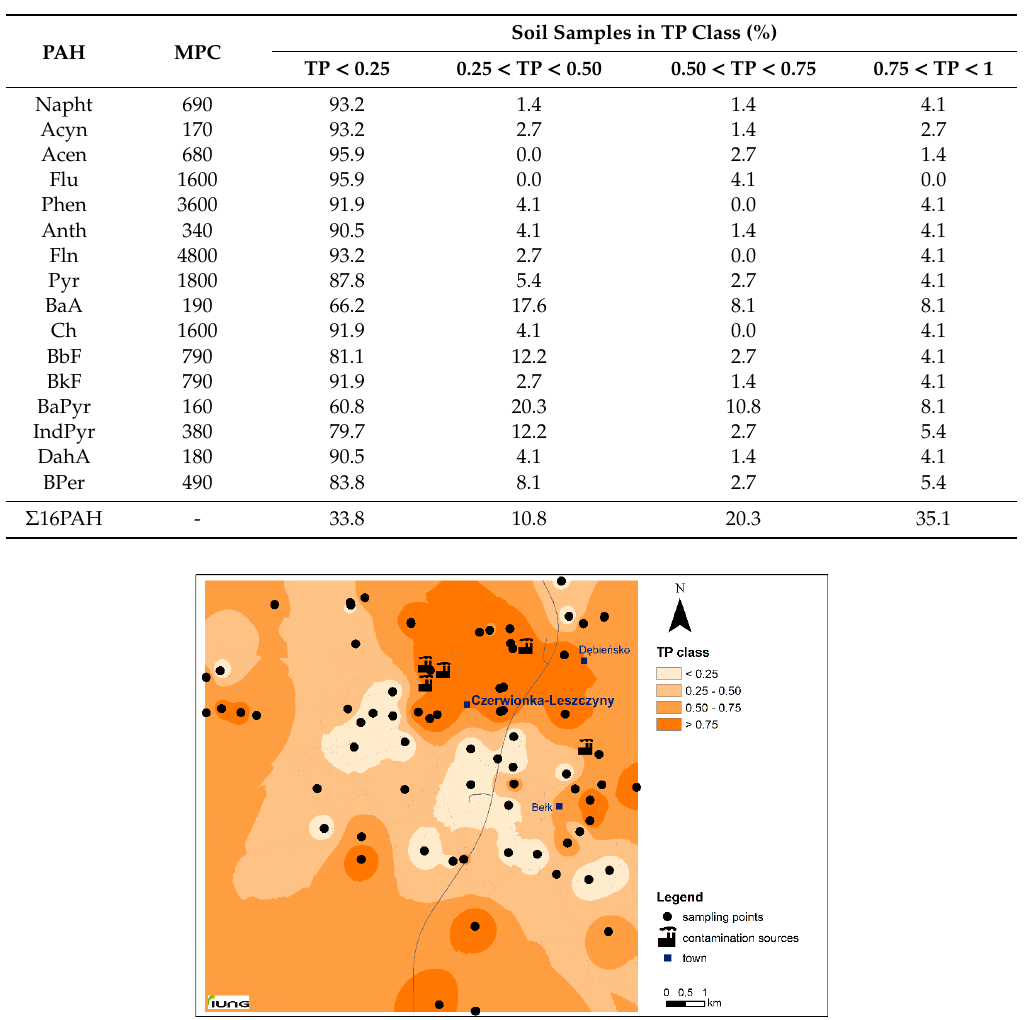
Table 4. Percentage share of soil samples in individual classes of toxic pressure (TP); TP classification